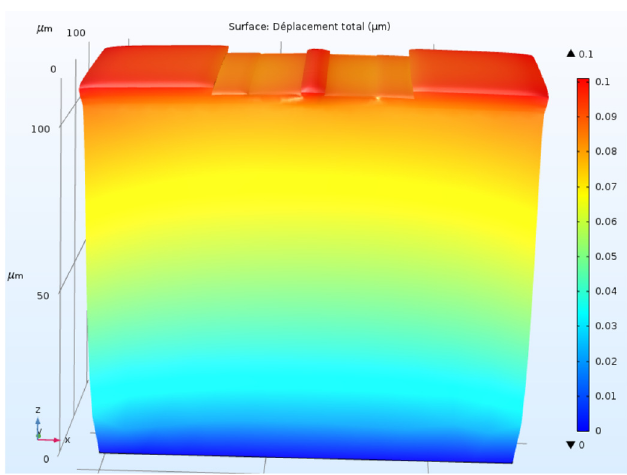
Fig. 4. Displacement distribution in the HEMT structure at P diss =9